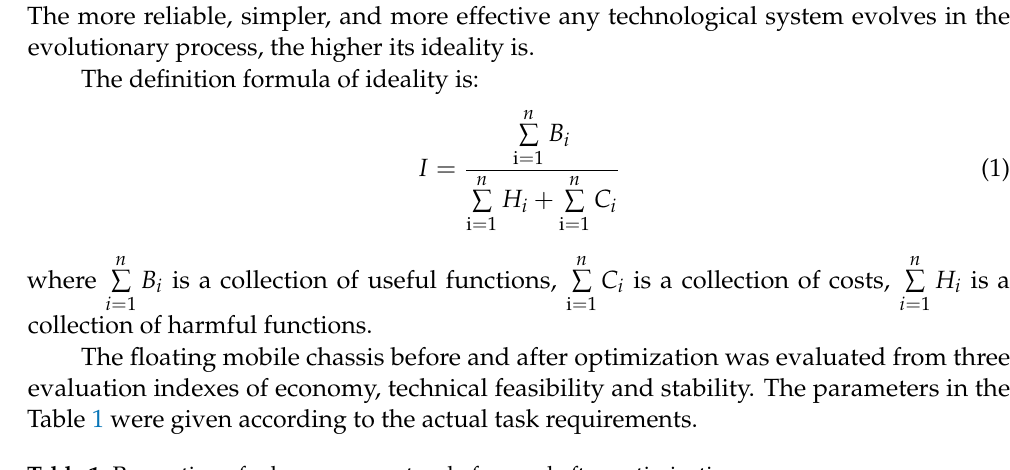
Table 1. Proportion of scheme parameters before and after optimization. Name Cost Technical Feasibility